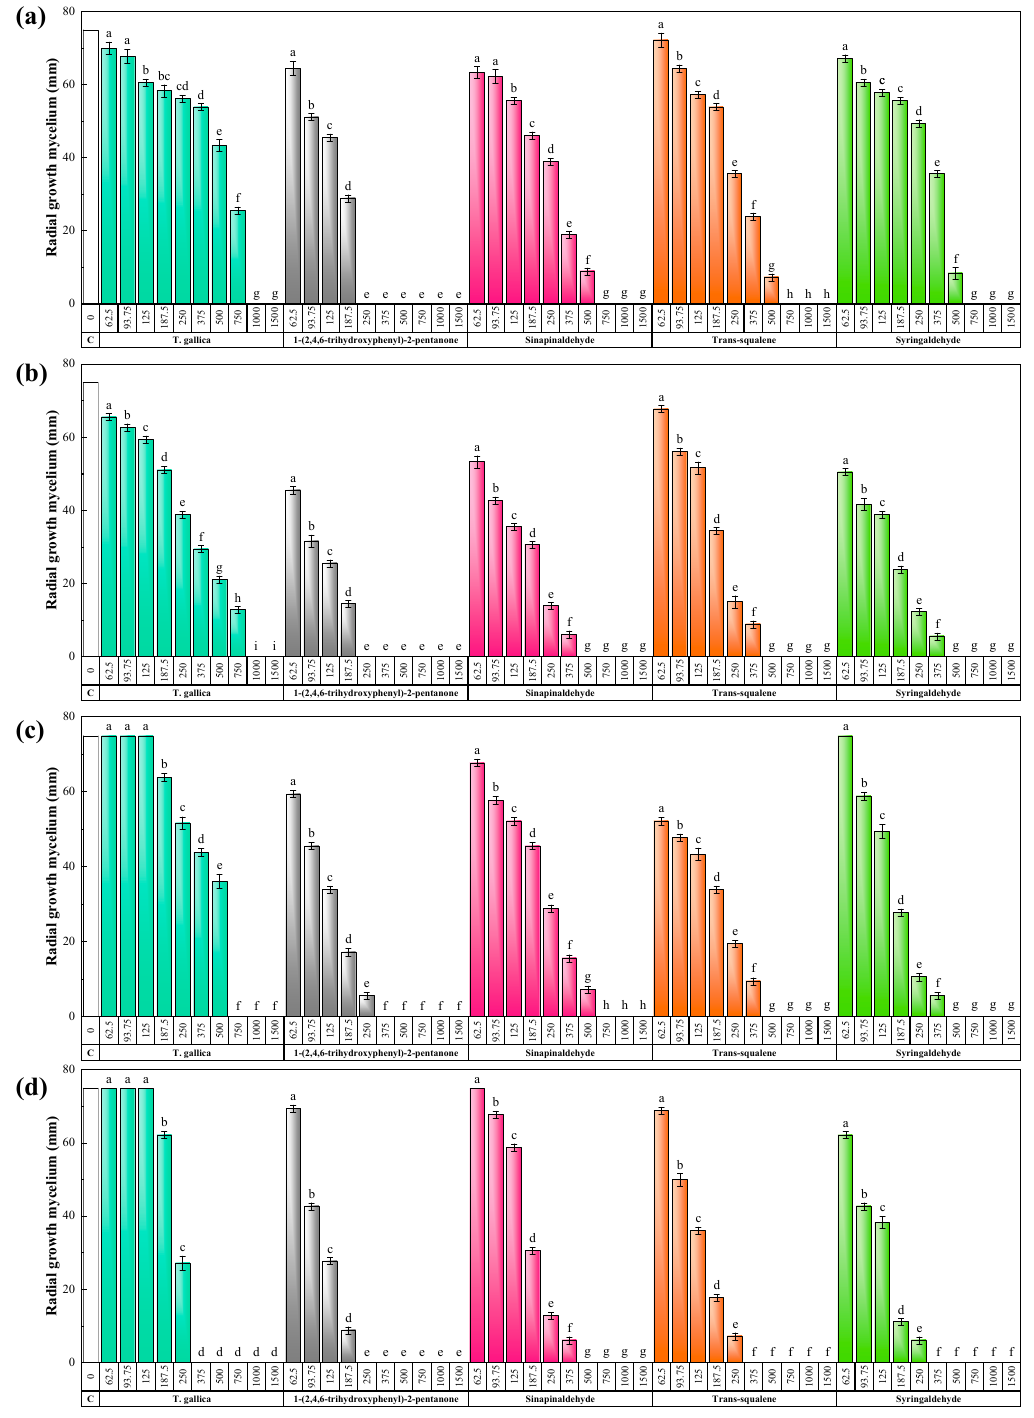
062 . 593 . 75125187 . 52503755007501000150062 . 593 . 75125187 . 52503755007501000150062 . 593 . 75125187 . 52503755007501000150062 . 593 . 75125187 . 52503755007501000150062 . 593 . 75125187 . 525037550075010001500 C Figure 3. Inhibition of the radial growth of the mycelium of ( a ) F. acuminatum , ( b ) F. culmorum , ( c ) F. equiseti, and ( d ) F. graminearum in the in vitro tests performed in PDA medium incorporating different concentrations (in the 62.5–1500 µ g · mL − 1 range) of T. gallica bark extract or of its main phytochemical constituents (viz., 1-(2,4,6-trihydroxyphenyl)-2-pentanone, sinapinaldehyde, trans -squalene, and syringaldehyde). The efficacies of concentrations labeled with the same letters are not statistically different at p < 0.05. Error bars represent standard deviations.